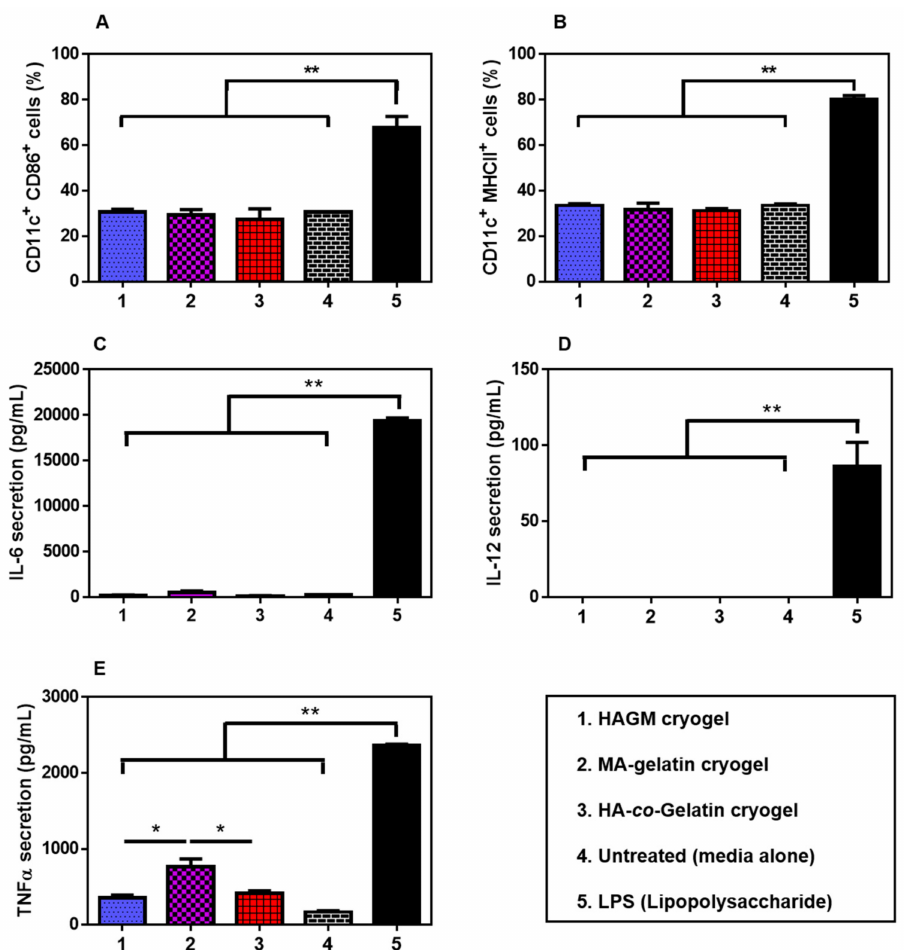
Figure 7. In vitro activation of bone marrow-derived dendritic cells (BMDCs). Fraction of activated ( A ) CD11c + CD86 + and ( B ) CD11c + MHCII + BMDCs stimulated after exposure to HAGM, HA- co -Gelatin, and MA-gelatin cryogels for 24 h. Concentrations of ( C ) IL-6; ( D ) IL-12; and ( E ) TNF- α from the cell culture supernatant when BMDCs were exposed to HAGM, HA- co -Gelatin, and MA-gelatin cryogels for 24 h. Lipopolysaccharide (LPS) at 100 ng/mL was used as a positive control and cryogel-free medium as a negative control (untreated). Values represent mean and SD ( n = 5). Data were analyzed using ANOVA (* p <